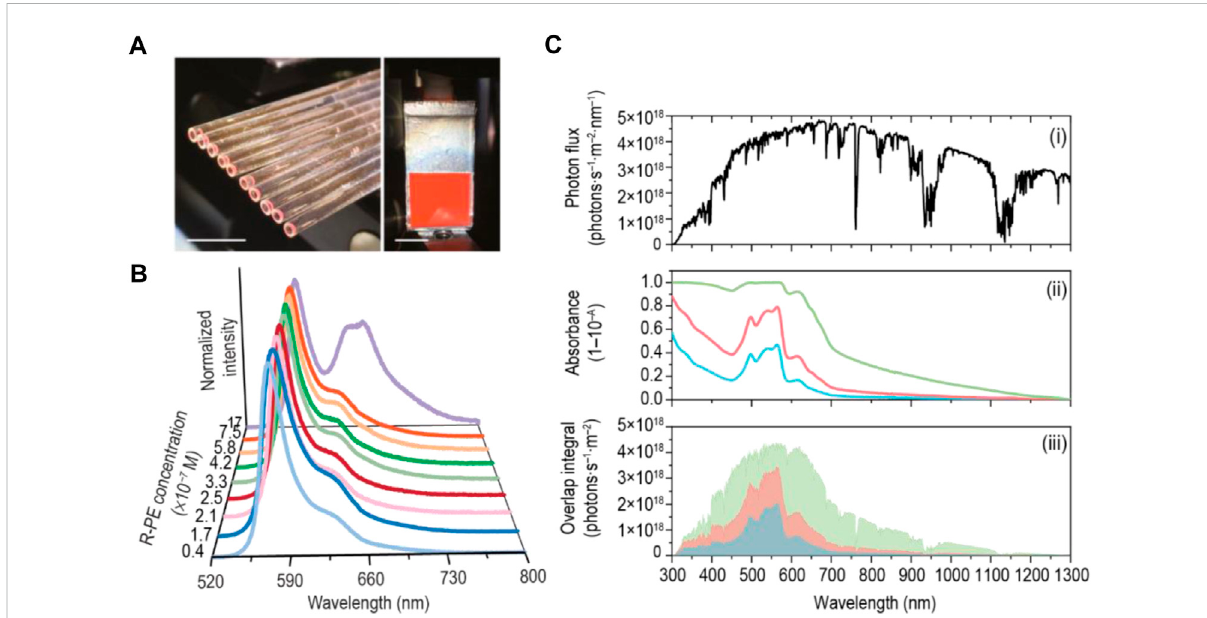
FIGURE 1 (A) Photographs of a bundle of cylindrical LSCs and a planar LSC based on R-PE solutions under AM1.5G. Scale bars: 1 cm; (B) Emission spectra of the R-PE solutions excited at 498 nm; (C) (i) Solar photon fl ux on Earth at AM1.5G, (ii) absolute absorbance of 1.7 × 10 – 7 M (blue line), 3.3 × 10 – 7 M (red line), and 17 × 10 – 7 M (green line), and (iii) integral overlap between the solar photon fl ux and the absolute absorbance. Reproduced with permission from Frias et al., 2019. Copyright 2019, Wiley-VCH Verlag GmbH & Co. KGaA,